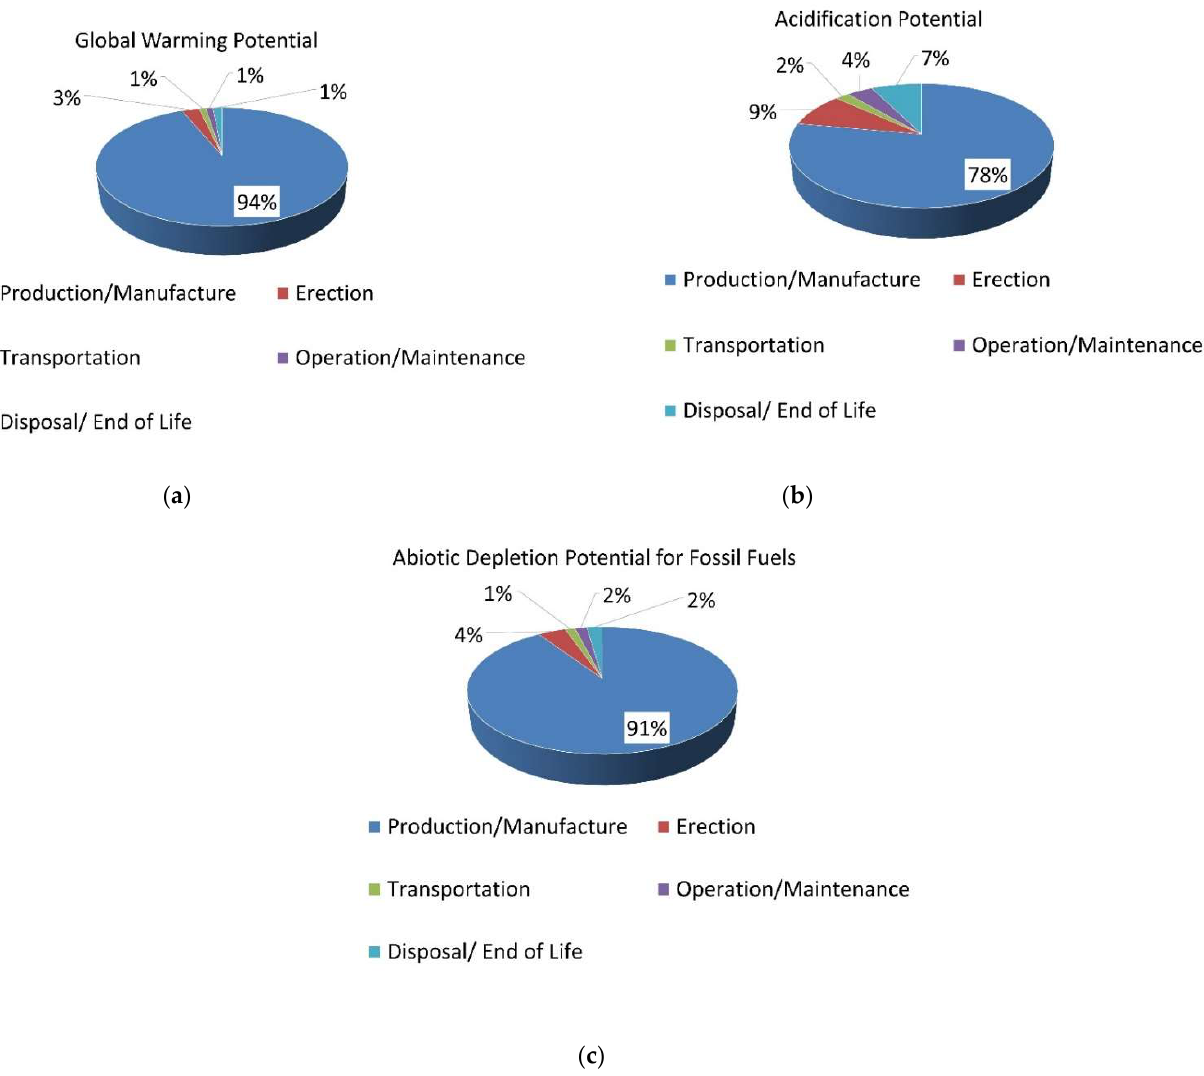
Figure 6. Contribution of each life cycle stage of the floating wind turbine to GWP ( a ), AP ( b ) and ADPF ( c ).